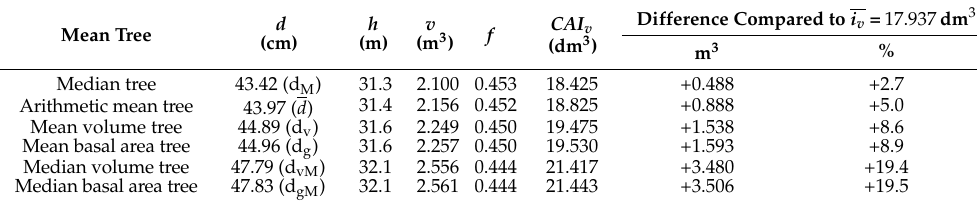
Table 5. Mean fir volume